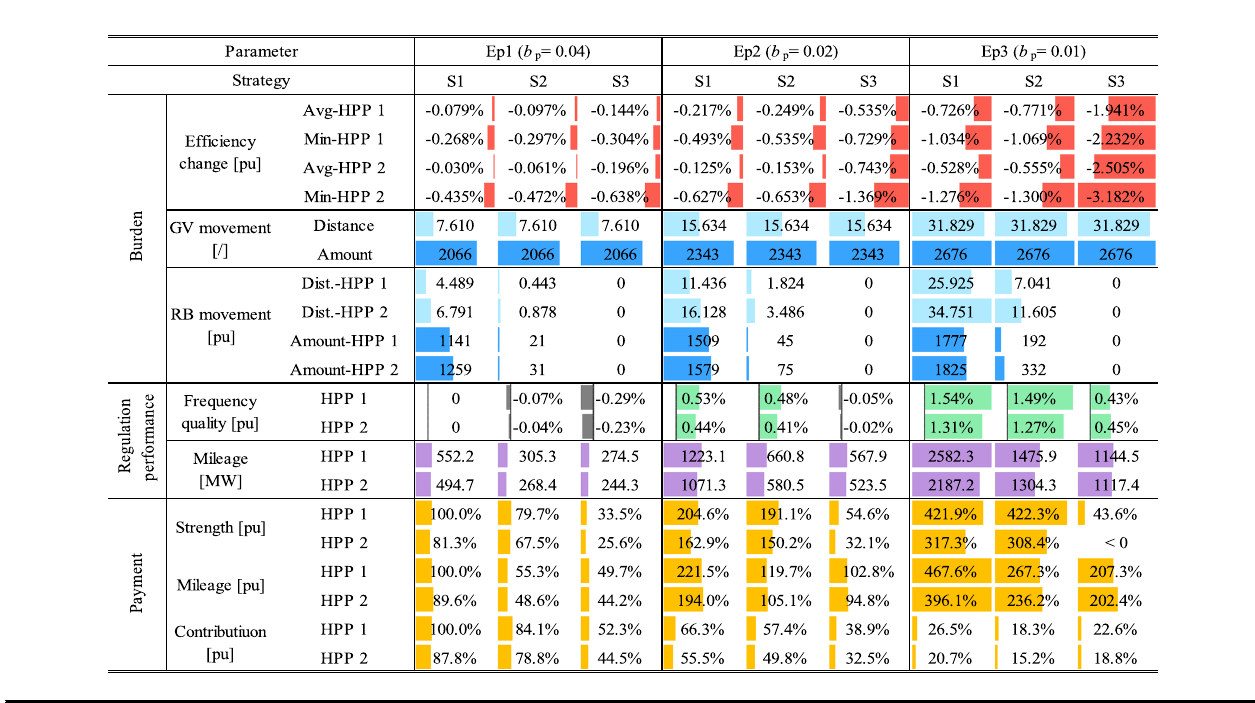
The bar in each cell indicates the relative magnitude of the values with the same color. The results of ef fi ciency loss are condensed from Table 2.The results of guide vane (GV) movement are based on HPP1,becausethereislittledifferenceontheindicatorsbetweentwoHPPs.Theoperatingpointdoesnotin fl uencemovementofGVandrunnerblade(RB)much,henceonlytheresultsfrompoint5are shown. For frequency quality, the values of the change of root mean square error are shown, and theyare condensed from the detailed values in Supplementary Table 5; negative and positivevalues are shown with green and gray bars, respectively, and positive values indicate better frequency quality. The regulation mileages are shown with purple bar, and the detailed results are in Fig. 4. The “ pu ” is short for per unit through out of this